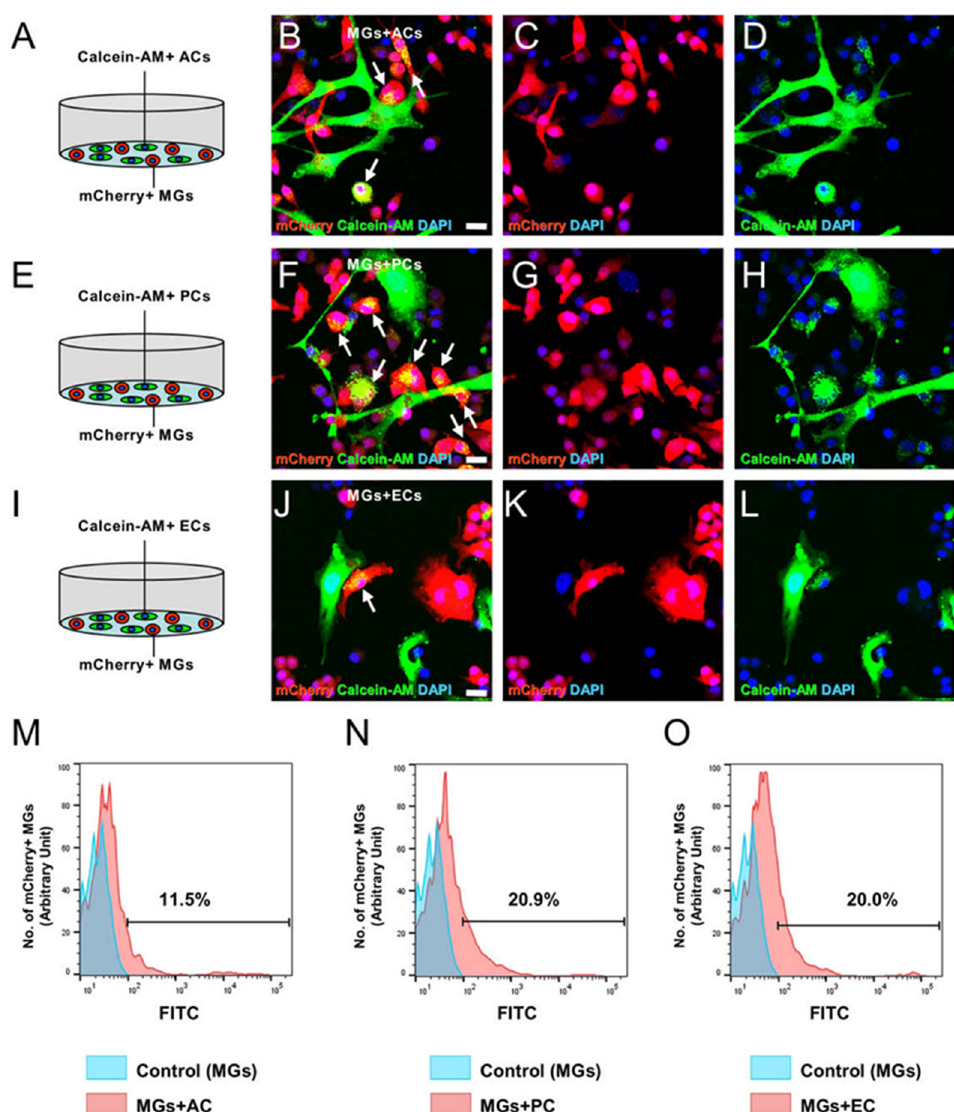
Figure 8. Transition of calcein-AM from ACs, PCs, or ECs into MGs after coincubation. Immunofluorescent examination for calcein-AM expression in MGs cocultured with ACs ( A – D ), PCs ( E – H ), or ECs ( I – L ) [mCherry (( B , C , F , G , J , K ): red); calcein-AM (( B , D , F , H , J , L ): green); DAPI (( B – D , F – H , J – L ): blue)]. Immunofluorescent analysis showed that calcein-AM was detectable in mCherry + cells cocultured with ACs (( B ), arrows), PCs (( F ), arrows), or ECs (( J ), arrows). The transition of calcein-AM from ACs ( M ), PCs ( N ), or ECs ( O ) to MGs was observed by FACS analysis. The control indicates the samples of MGs alone. The results represent triplicates. Scale bars: 20 µm ( B , F , J ). Abbreviations: AC, astrocyte; DAPI, 4’,6-diamidino-2-phenylindole; EC, endothelial cell; MG, microglial cell; PC, pericyte.